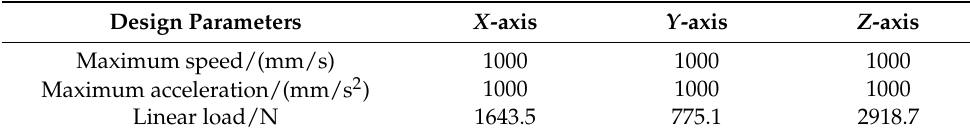
Table 2. Main parameters of the three-axis translation table.